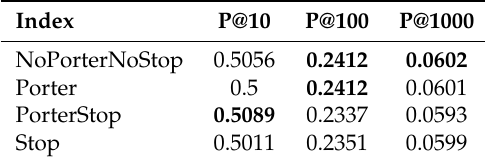
Table 8. DirichletLM+QE+RF for T2: P@10, P@100 and P@1000. The highest values are in